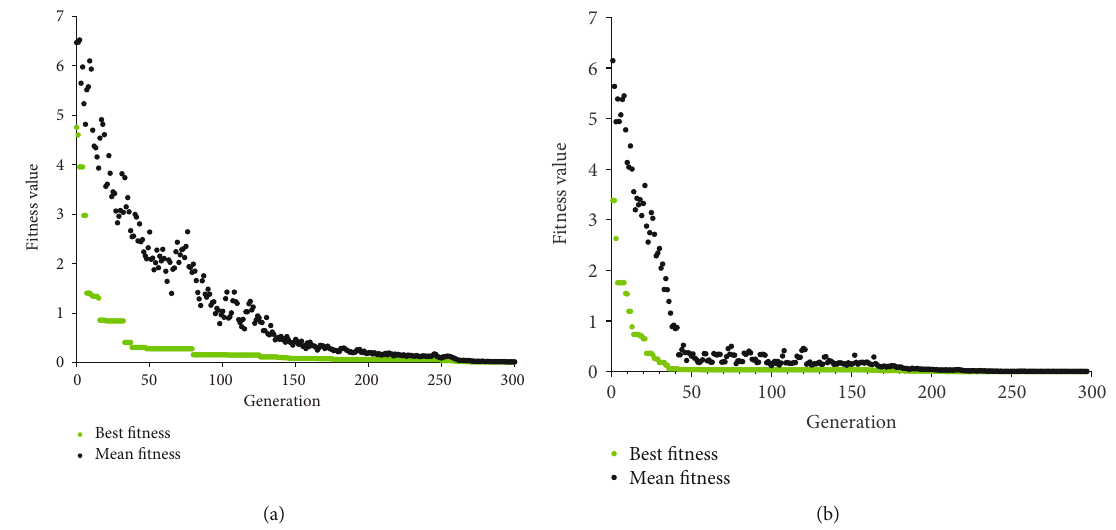
Figure 5: Variation in the mean fi tness and best fi tness of each generation.